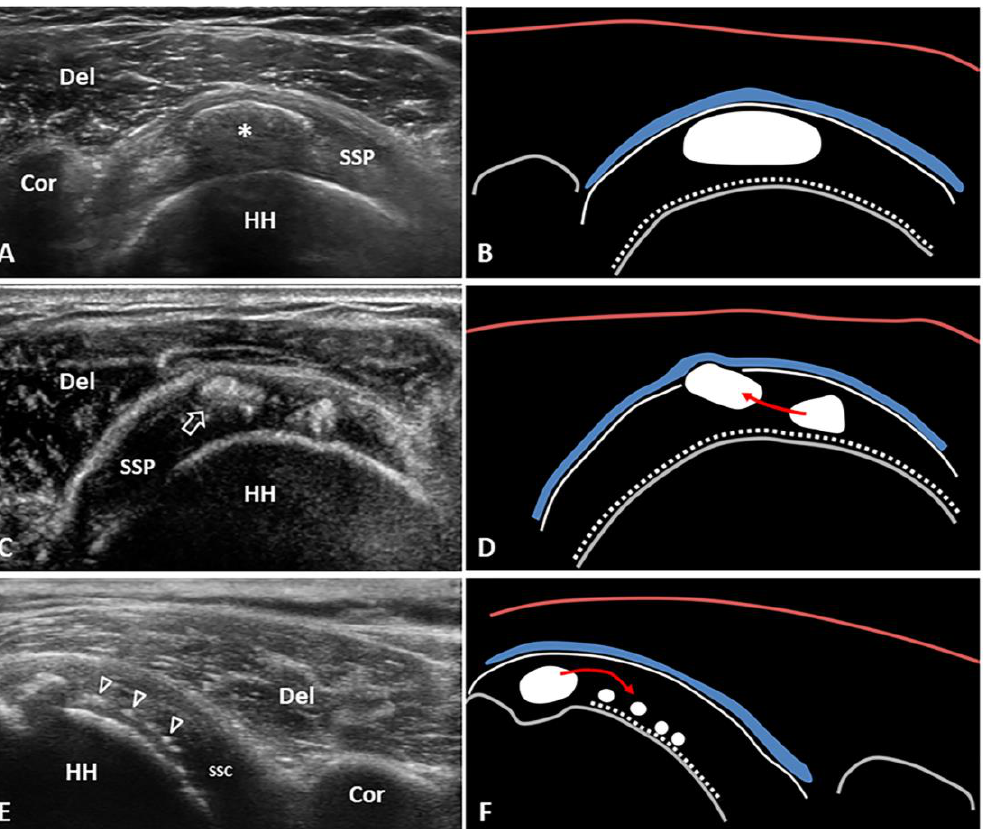
Figure 2. Short-axis view of the supraspinatus ( SSP ) tendon with elliptical calcification ( asterisk ) in resting phase—i.e., type 1 Gartner and Heyer ( A , B ). Short-axis view of the SSP tendon with intratendinous bursal side migration pattern of a softly hydrated fragment ( white void arrow ) of calcific deposits with sub-bursal space involvement ( C , D ). Long-axis view of the subscapularis ( SSC ) tendon with intratendinous articular side migration pattern of multiple hydroxyapatite calcium crystals ( white void arrowheads ) towards the surface of the humeral head ( E , F ). The latter might be a “migratory pattern” possibly predisposing to ‘post-calcific’ frozen shoulder. Del: deltoid, Cor: coracoid, HH: humeral head, blue lines: subacromial bursa, white dotted lines: cartilage, white lines: outer surface of the rotator cuff tendons, red lines: superficial fascia of the deltoid muscle, grey lines: bony surface, red arrow: possible direction of migration.